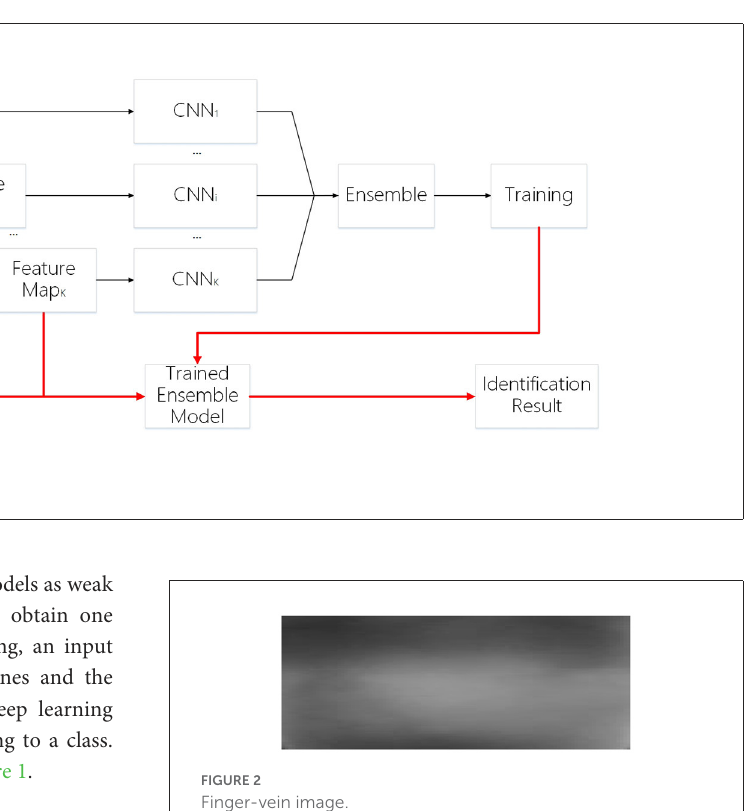
FIGURE2 Finger-vein